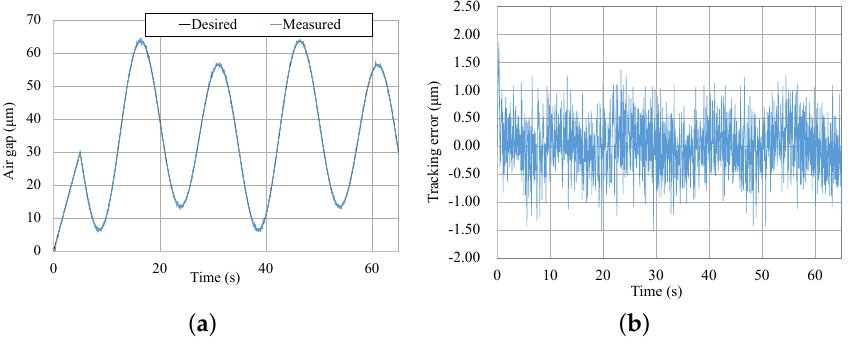
Figure 14. Tracking results comparison of the step trajectory. ( a ) Tracking result of desired trajectory. ( b ) Tracking error of desired